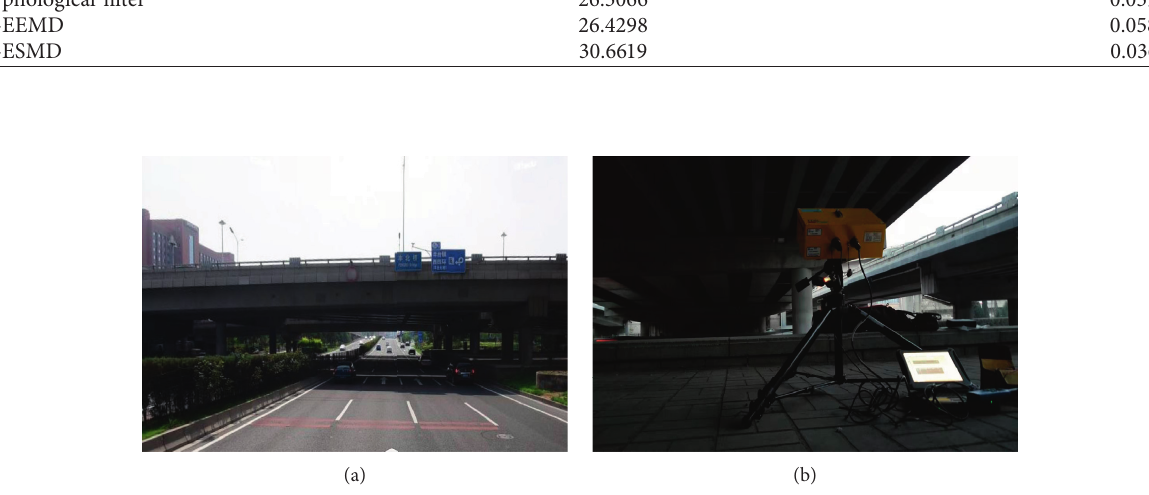
Figure 6: Fengbei Bridge and IBIS-S instrument layout. (a) Fengbei Bridge and (b) the dynamic deflection measurement of the Fengbei Bridge by IBIS-S.